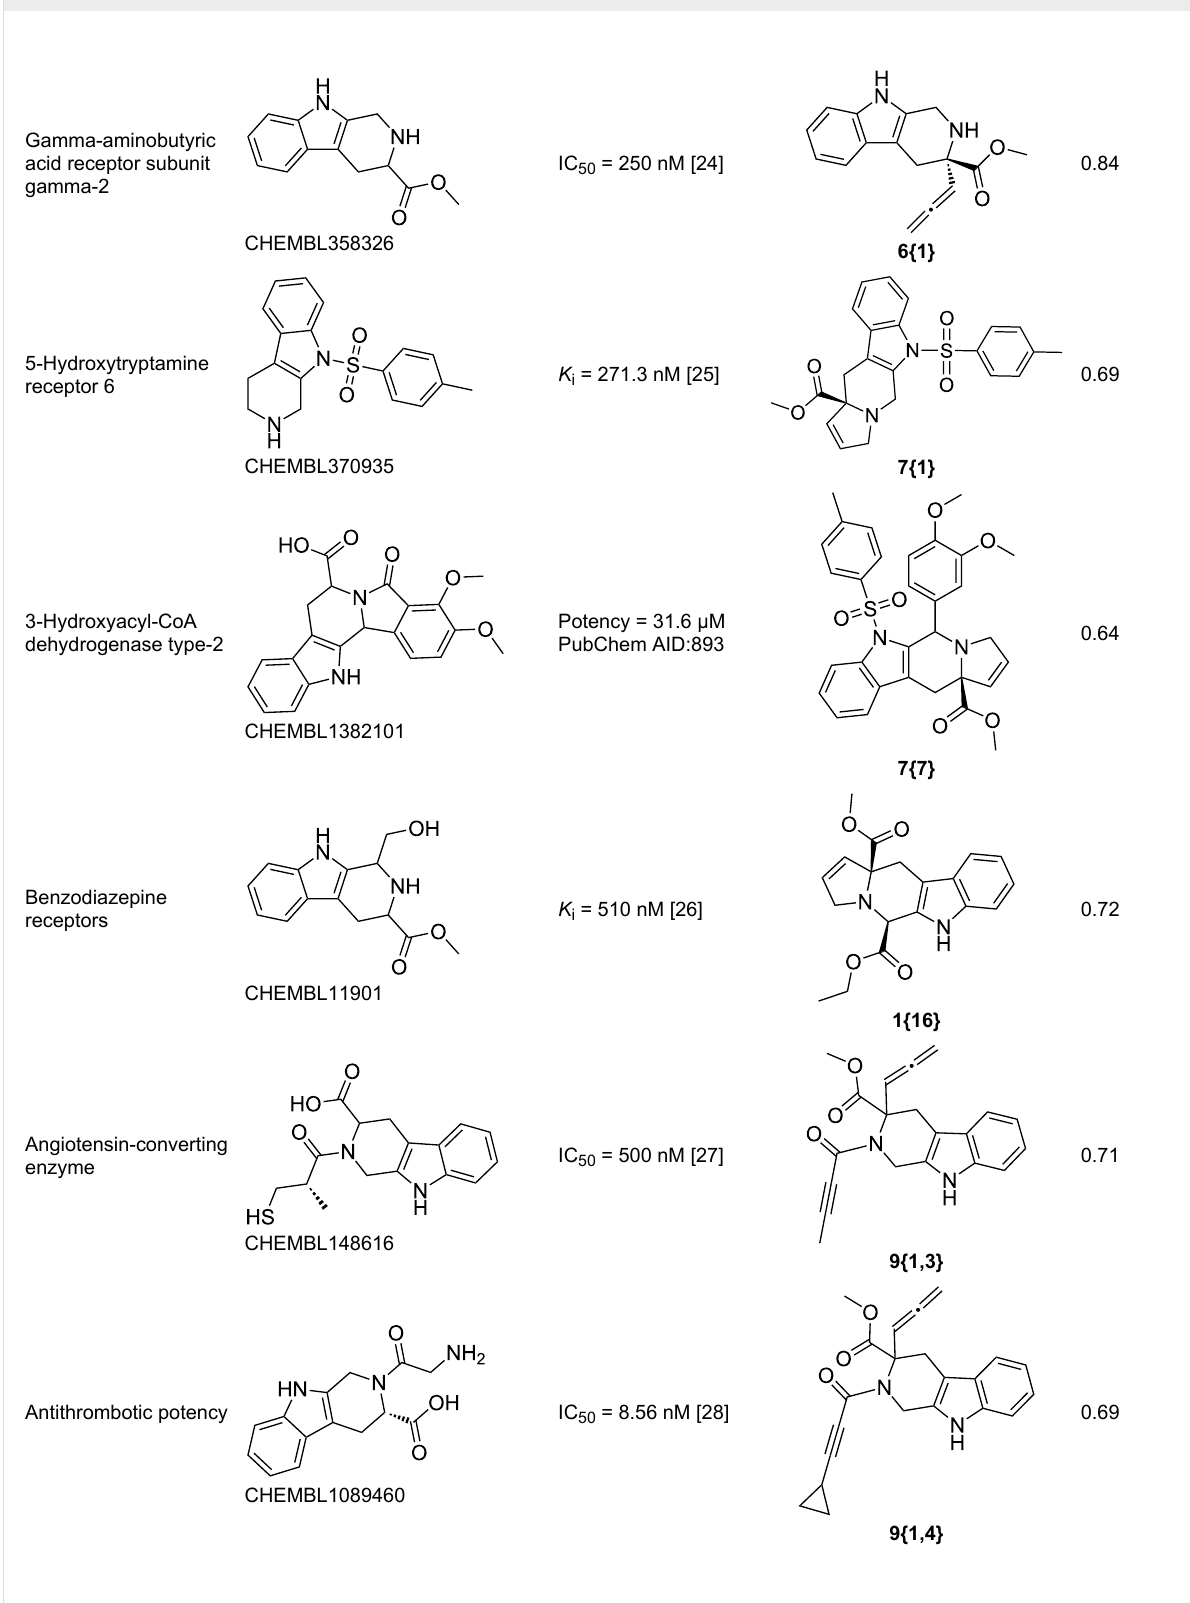
Table 4: Potential targets of β -carbolines based upon bioactivity data in ChEMBL.